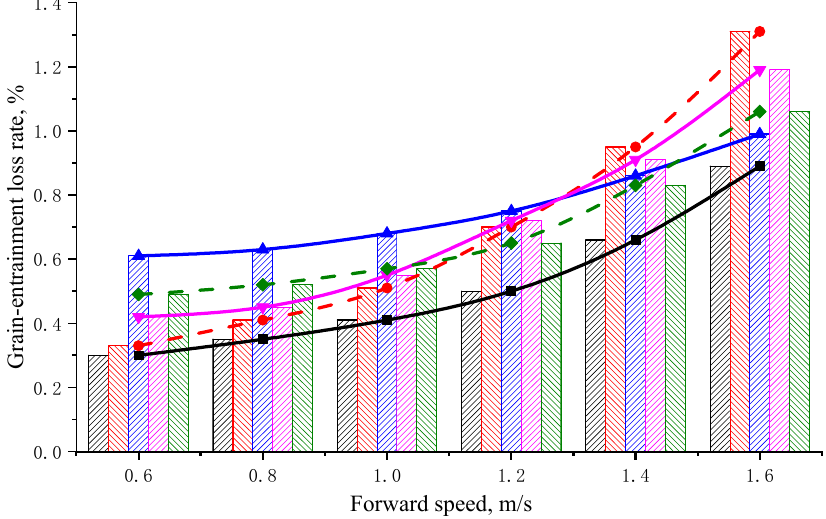
Forward speed, m/s Forward speed, m/s Figure 8. Diagram for the variation of entrainment loss rate at different forward speeds under various Figure 8. Diagram for the variation of entrainment loss rate at different forward speeds under various Figure 8. Diagram for the variation of entrainment loss rate at different forward speeds under various Figure 8. Diagram for the variation of entrainment loss rate at different forward speeds under various Figure 8. Diagram for the variation of entrainment loss rate at different forward speeds under various Figure 8. Diagram for the variation of entrainment loss rate at di ff erent forward speeds under various Figure 8. Diagram for the variation of entrainment loss rate at different forward speeds under various threshing gaps, the black ▨ and - ■ - are initial gap of 20 mm, the red ▧ and - ● - are threshing drum threshing gaps, the black ▨ and - ■ - are initial gap of 20 mm, the red ▧ and - ● - are threshing drum threshing gaps, the black ▨ and - ■ - are initial gap of 20 mm, the red ▧ and - ● - are threshing drum threshing gaps, the black ▨ and - ■ - are initial gap of 20 mm, the red ▧ and - ● - are threshing drum threshing gaps, the black ▨ and - ■ - are initial gap of 20 mm, the red ▧ and - ● - are threshing drum threshing gaps, the black and - (cid:4) - are initial gap of 20 mm, the red threshing gaps, the black ▨ and - ■ - are initial gap of 20 mm, the red ▧ and - ● - are threshing drum adjustment type of 10 mm, the blue ▨ and - ▲ - are concave adjustment type of 30 mm, the pink ▨ and adjustment type of 10 mm, the blue ▨ and - ▲ - are concave adjustment type of 30 mm, the pink ▨ and adjustment type of 10 mm, the blue ▨ and - ▲ - are concave adjustment type of 30 mm, the pink ▨ and adjustment type of 10 mm, the blue ▨ and - ▲ - are concave adjustment type of 30 mm, the pink ▨ and adjustment type of 10 mm, the blue ▨ and - ▲ - are concave adjustment type of 30 mm, the pink ▨ and and - (cid:78) - are concave adjustment type of 30 mm, the pink and adjustment type of 10 mm, the blue ▨ and - ▲ - are concave adjustment type of 30 mm, the pink ▨ and - ▼ - are concave adjustment type of 10 mm, the green ▧ and - ♦ - are threshing drum adjustment type - ▼ - are concave adjustment type of 10 mm, the green ▧ and - ♦ - are threshing drum adjustment type - ▼ - are concave adjustment type of 10 mm, the green ▧ and - ♦ - are threshing drum adjustment type - ▼ - are concave adjustment type of 10 mm, the green ▧ and - ♦ - are threshing drum adjustment type - ▼ - are concave adjustment type of 10 mm, the green ▧ and - ♦ - are threshing drum adjustment type and - (cid:7) - are threshing drum adjustment type of - ▼ - are concave adjustment type of 10 mm, the green ▧ and - ♦ - are threshing drum adjustment type of 30 mm. of 30 mm. of 30 mm. of 30 mm. of 30 mm. 30 of 30 mm.